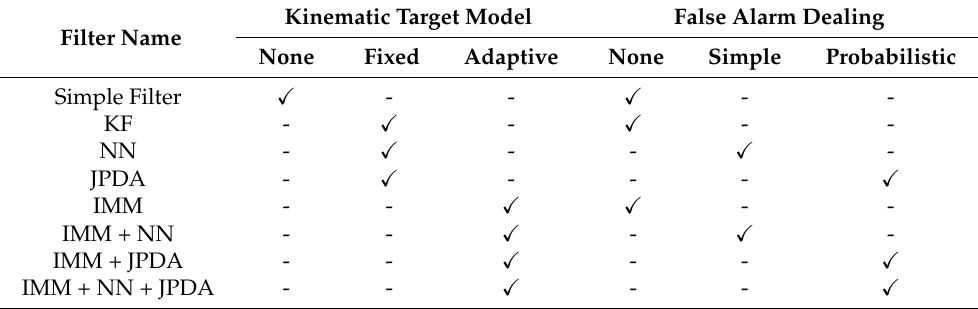
Table 1. Summary of the examined filters’ features. Filter